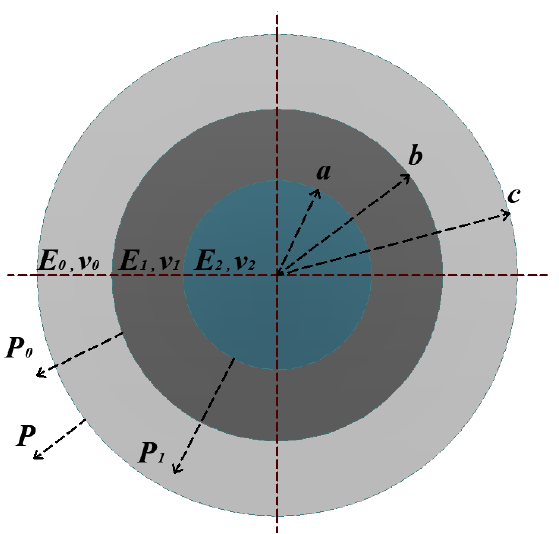
Figure 5. Prediction model for the elastic modulus of foamed concrete.